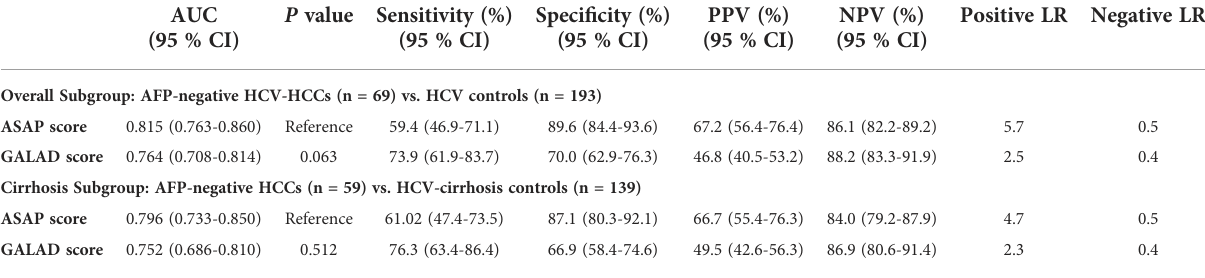
TABLE 4 Diagnostic performances of the ASAP and the GALAD score for detecting AFP-negative HCV-HCC (AFP<20 ng/ml) in the overall group and the cirrhosis subgroup.